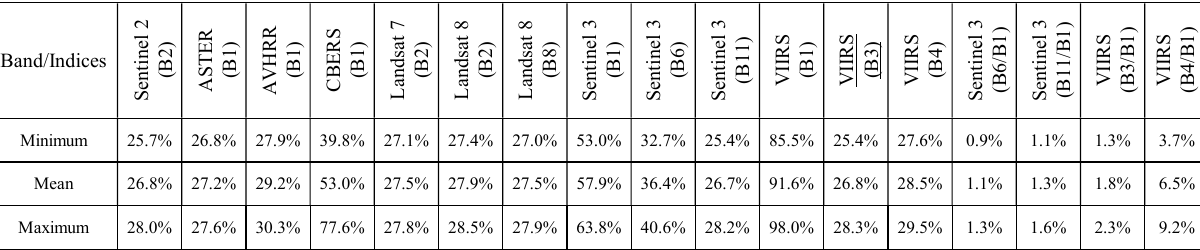
Table 4. Minimum, maximum and mean flower coverage required for 1 SD change in reflectance for non-MODIS synthetic pixels